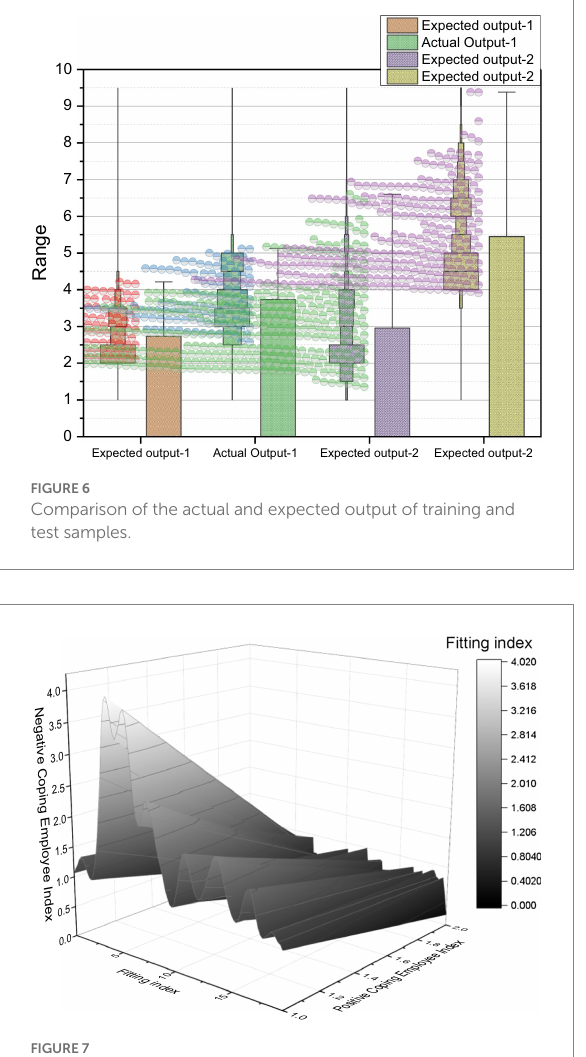
FIGURE 7 Modified model and fit